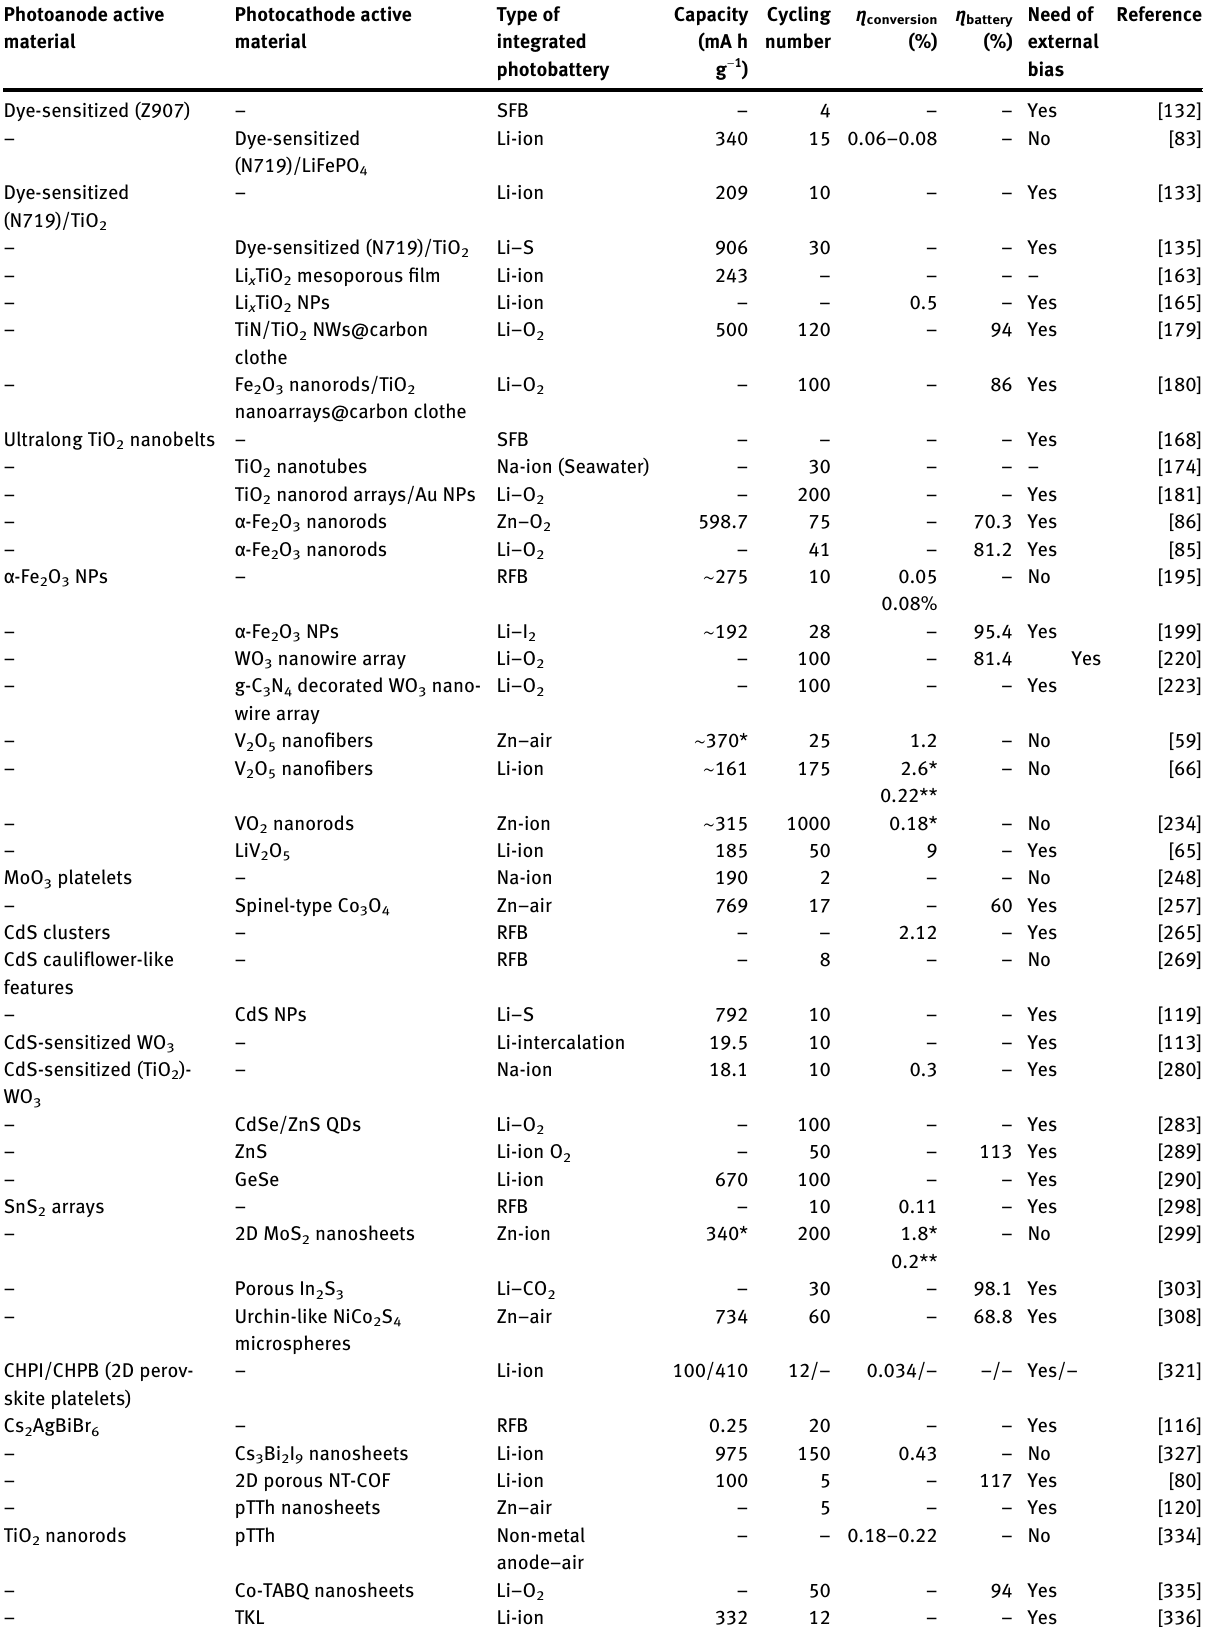
Table  : Classi fi cation and main characteristics of described two-electrode integrated photo-rechargeable